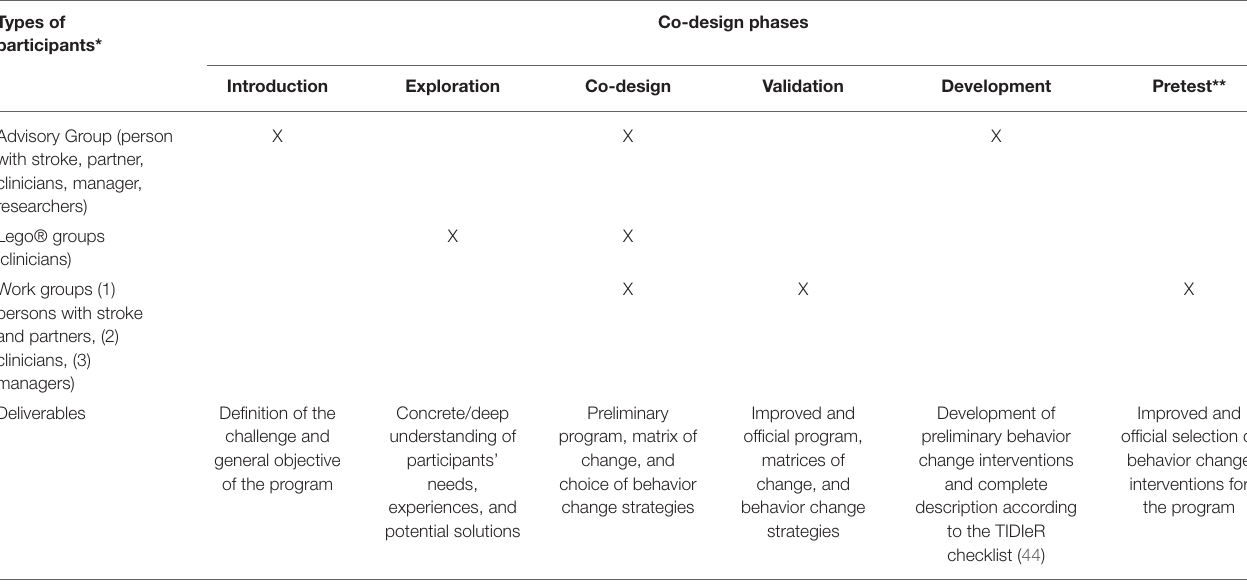
TABLE 1 | Course of the study and related deliverables according to the co-design methodology by Morales et al. (38) and the Intervention Mapping approach (32). Types of